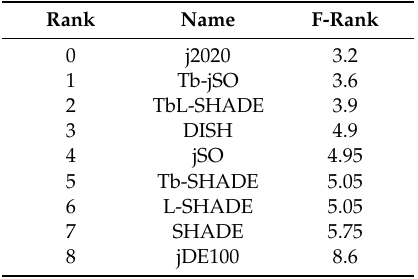
Table 36. The Friedman ranks of comparative algorithms on CEC2020 in 10 D .